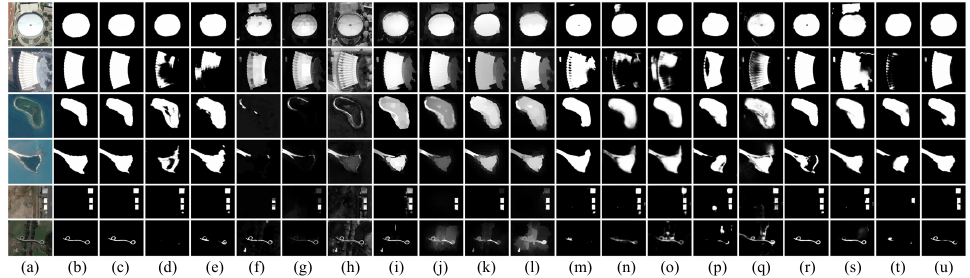
Figure 3. Visualization comparison of different optical RSI saliency models on several challenging scenes. ( a ): RGB, ( b ): GT, ( c ): Ours, ( d ): PDFNet, ( e ): LVNet, ( f ): RBD, ( g ): RCRR, ( h ): DSG, ( i ): MILPS, ( j ): SSD, ( k ): SPS, ( l ): ASD, ( m ): R3Net, ( n ): DSS, ( o ): RADF, ( p ): RFCN, ( q ): PoolNet ( r ): BASNet ( s ): EGNet ( t ): CPD, ( u ):